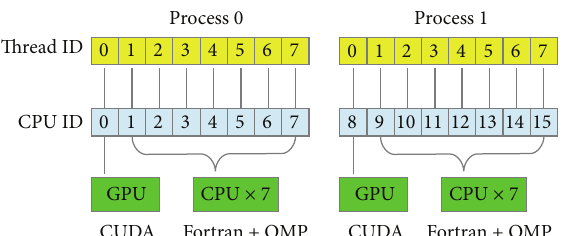
Figure 2: An example to show the processes and threads in cudaFDTD: 2 processes are started and each process controls 8